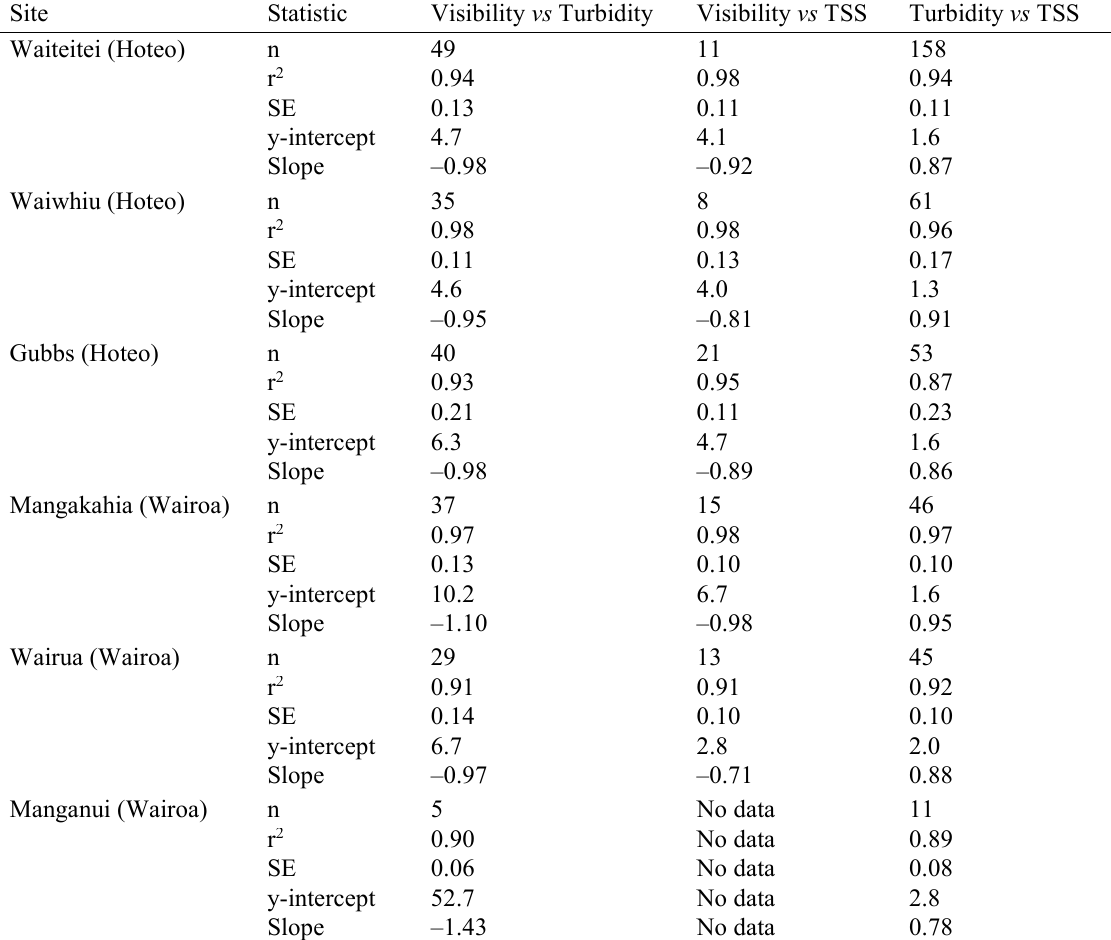
Table 2 Linear regression analysis summary for the mutual relationships of log-transformed visual clarity, turbidity and TSS for the six (3 Hoteo, 3 Wairoa) monitoring